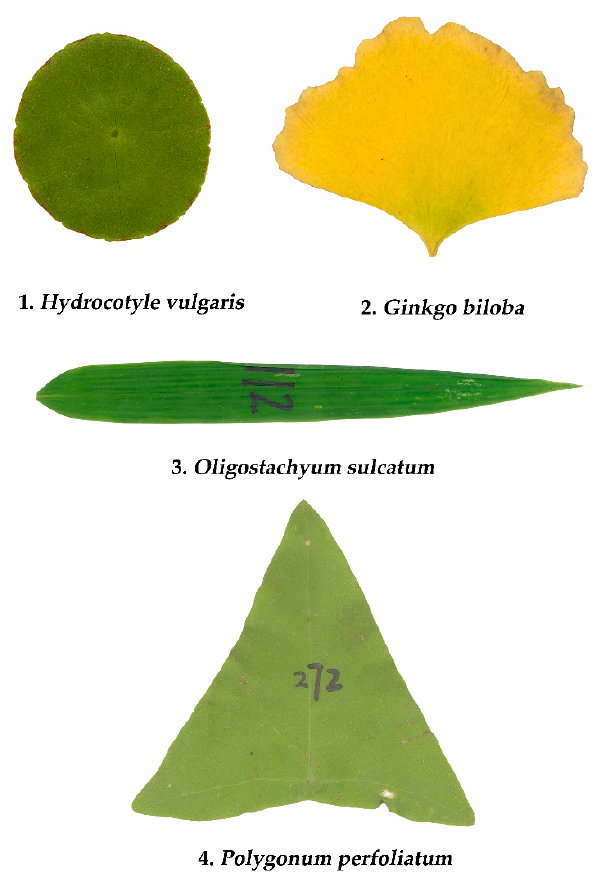
Figure 1. Examples of the four types of leaf shapes. Table 1. Collection information of four representative leaf shapes. All leaves were collected in Nanjing city, Jiangsu Province, China, in